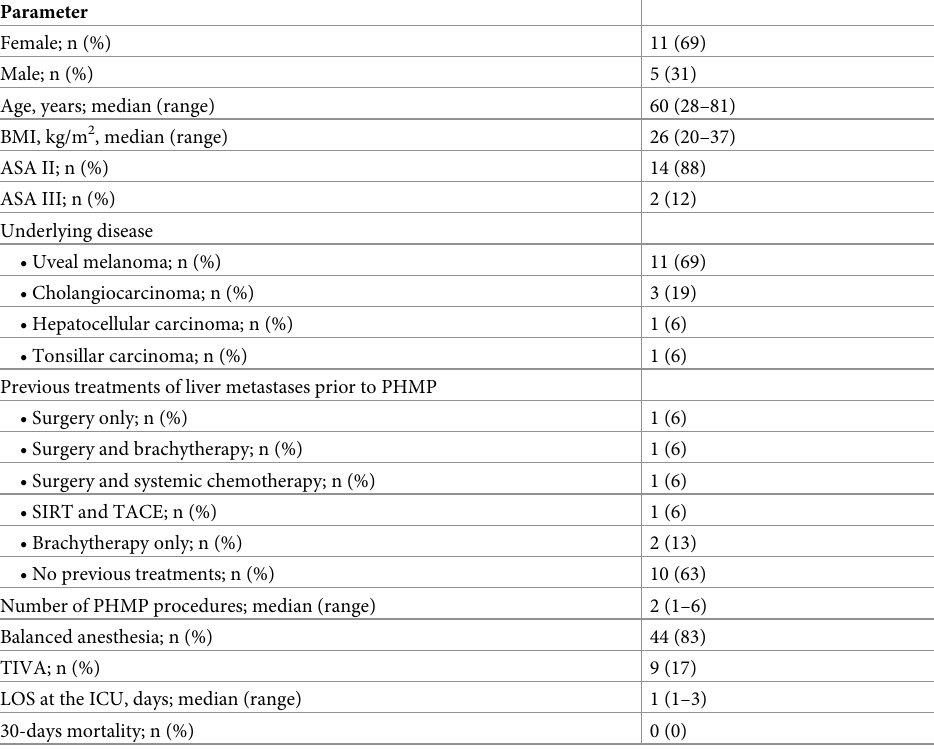
Table 1. Patient’s characteristics of percutaneous hepatic melphalan perfusion. Parameter